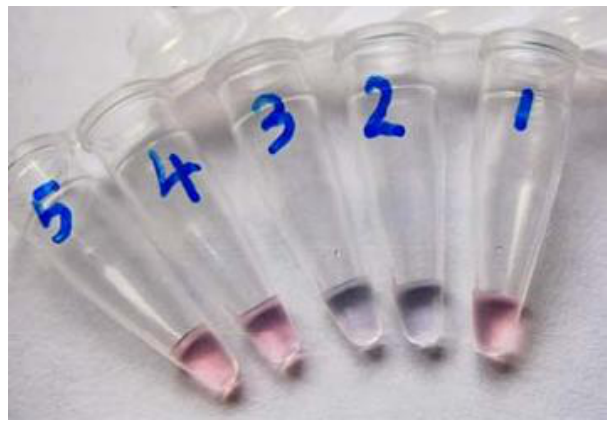
Figure 3. Photographic image of MUA-AuNPs, with their colour visibly changed in the presence of Pb 2+ . (1) Deionized water; (2) 0.05 mM Pb 2+ ; (3) 0.025 mM Pb 2+ ; (4) 0.01 mM Pb 2+ ; (5) 0.005 mM Pb 2+